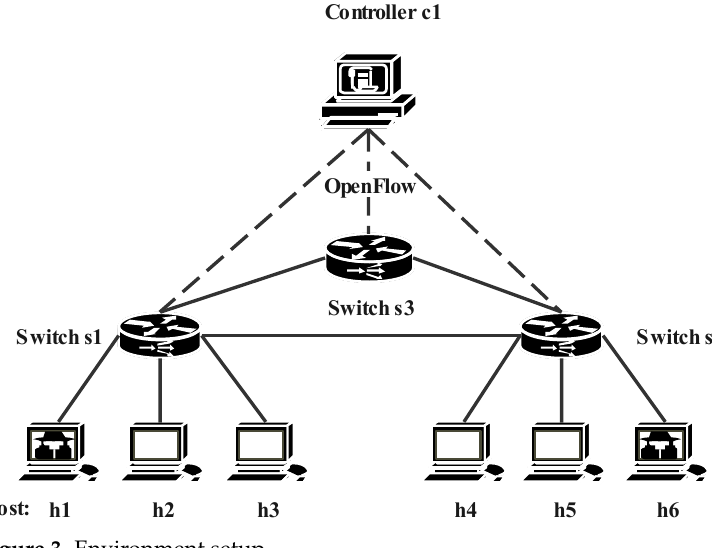
Figure 3. Environment setup.